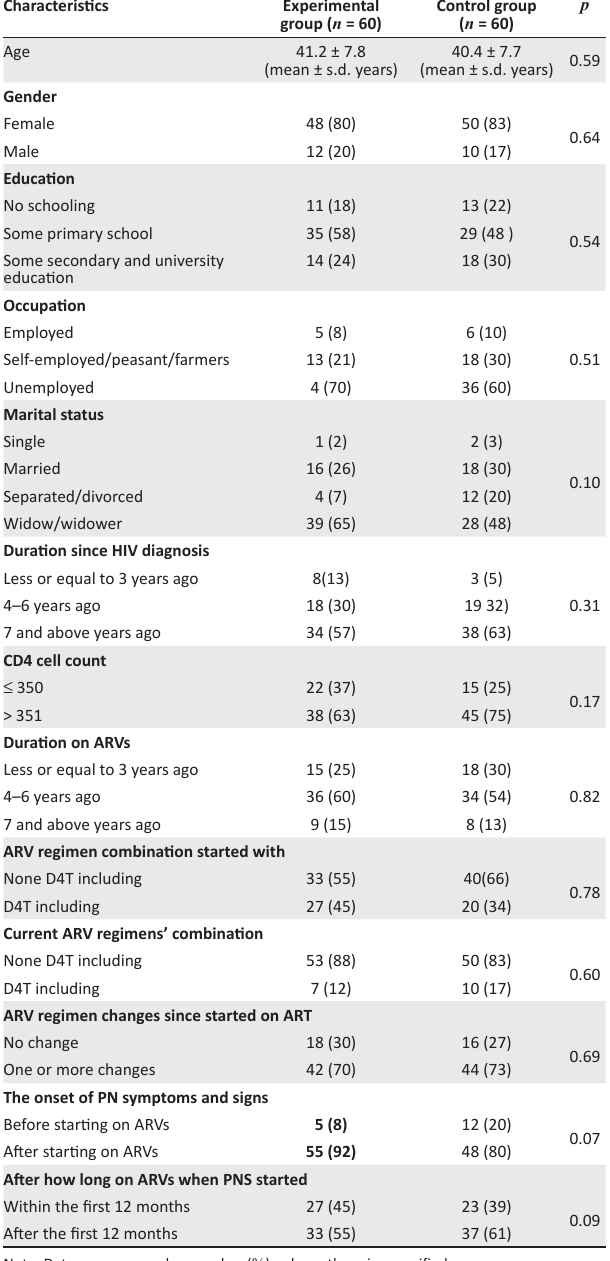
TABLE 1: Demographic and health status characteristics of the participants: comparison between the experimental and control groups at baseline ( n = 120).